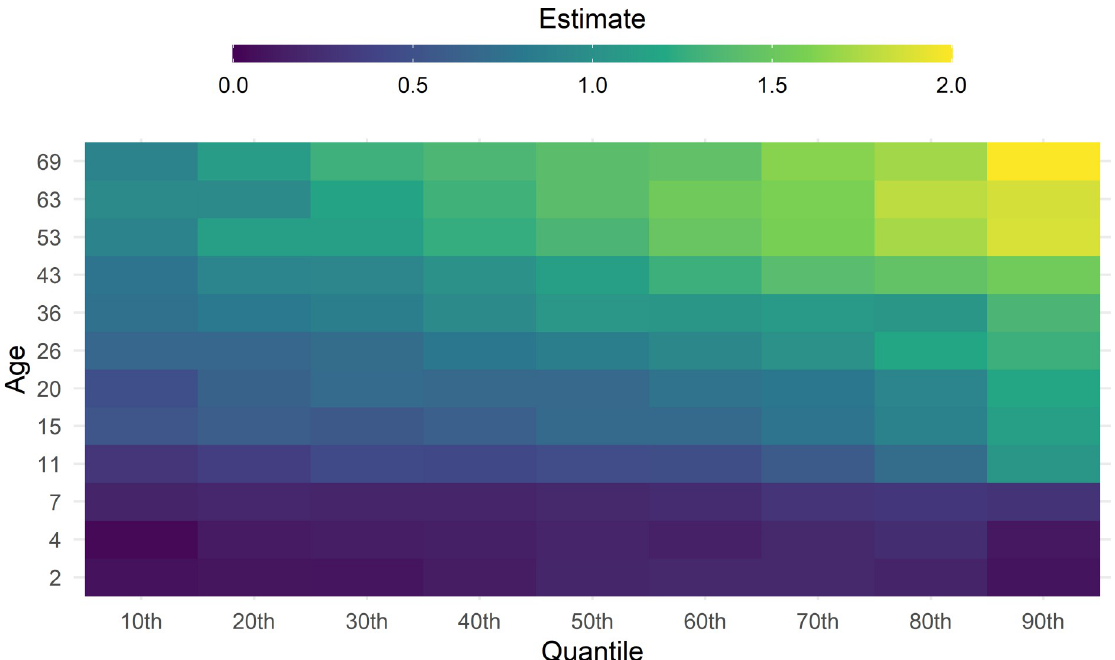
Fig 3. Heatmap of the association between Khera et al.[4] polygenic index and BMI across life. Drawn from quantile regressions including adjustment for sex, repeated at each follow up (y-axis) and decile (x-axis). The size of the coefficient is represented by a colour (see legend). Coefficients are interpreted analogously to linear regression: for example, Q50 shows the median (rather than mean) difference in body mass index per 1 SD increase in polygenic index.